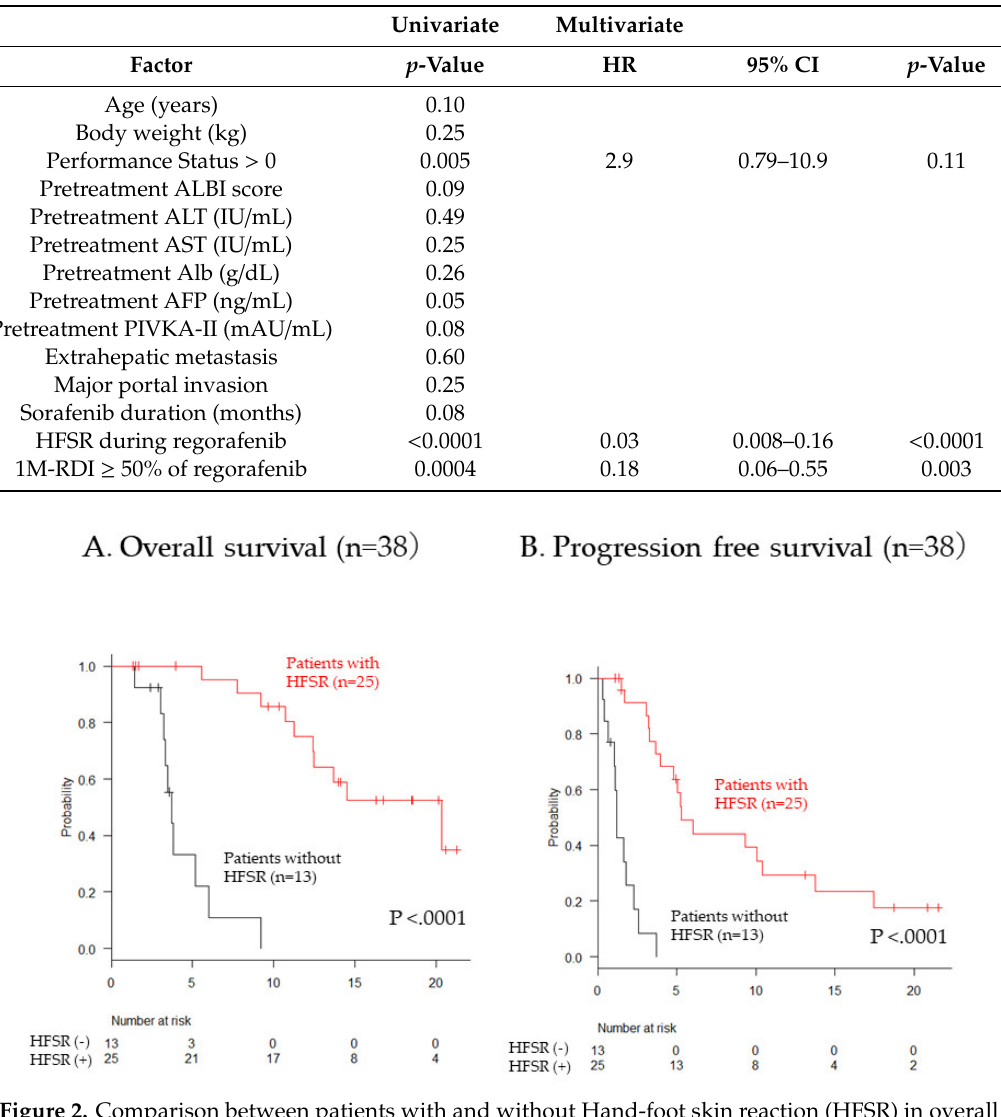
Figure 2. Comparison between patients with and without Hand-foot skin reaction (HFSR) in overall survival ( A ) and progression free survival ( B survival ( A ) and progression free survival ( B ).